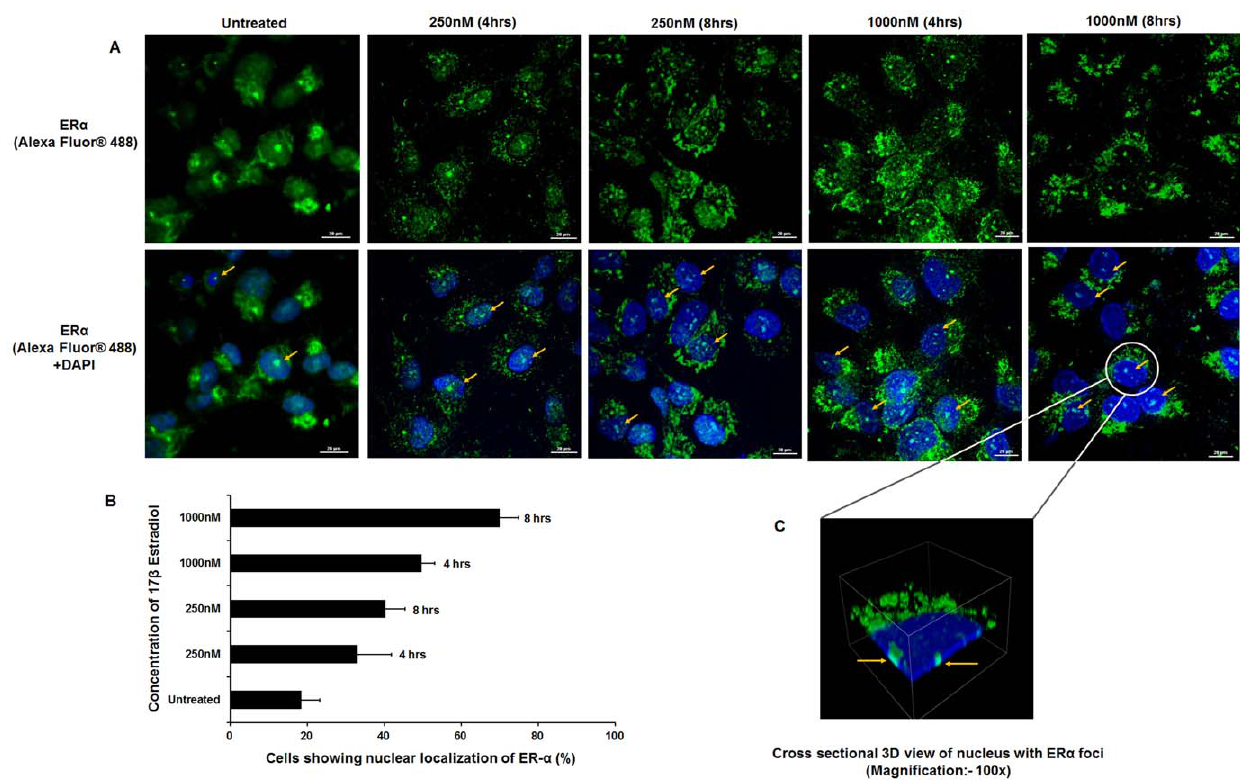
Figure 4. Nuclear localization of ER a on 17 b estradiol treatment in HTM cells. A : Confocal images of HTM cells upon dose (250 mM & 1000 mM) and time (4 hr and 8 hr) dependent treatment with 17 b estradiol. Cells were stained with human specific ER a -antibody followed by Alexa Fluor H 488 labeled anti-rabbit secondary antibody ( Upper panel ). For all conditions, corresponding superimposed image with DAPI are given ( Lower panel ). Arrows point to the cells where nuclear localization of ER a was observed. B : Histogram showing the percentage of HTM cells with ER a localized in the nucleus upon treatment with 17 b estradiol in a dose and time dependent manner. Each experiment was done in triplicate. C : Cross sectional 3D view of nuclear localization of ER a in HTM cell is shown [Scale bar: 20 m